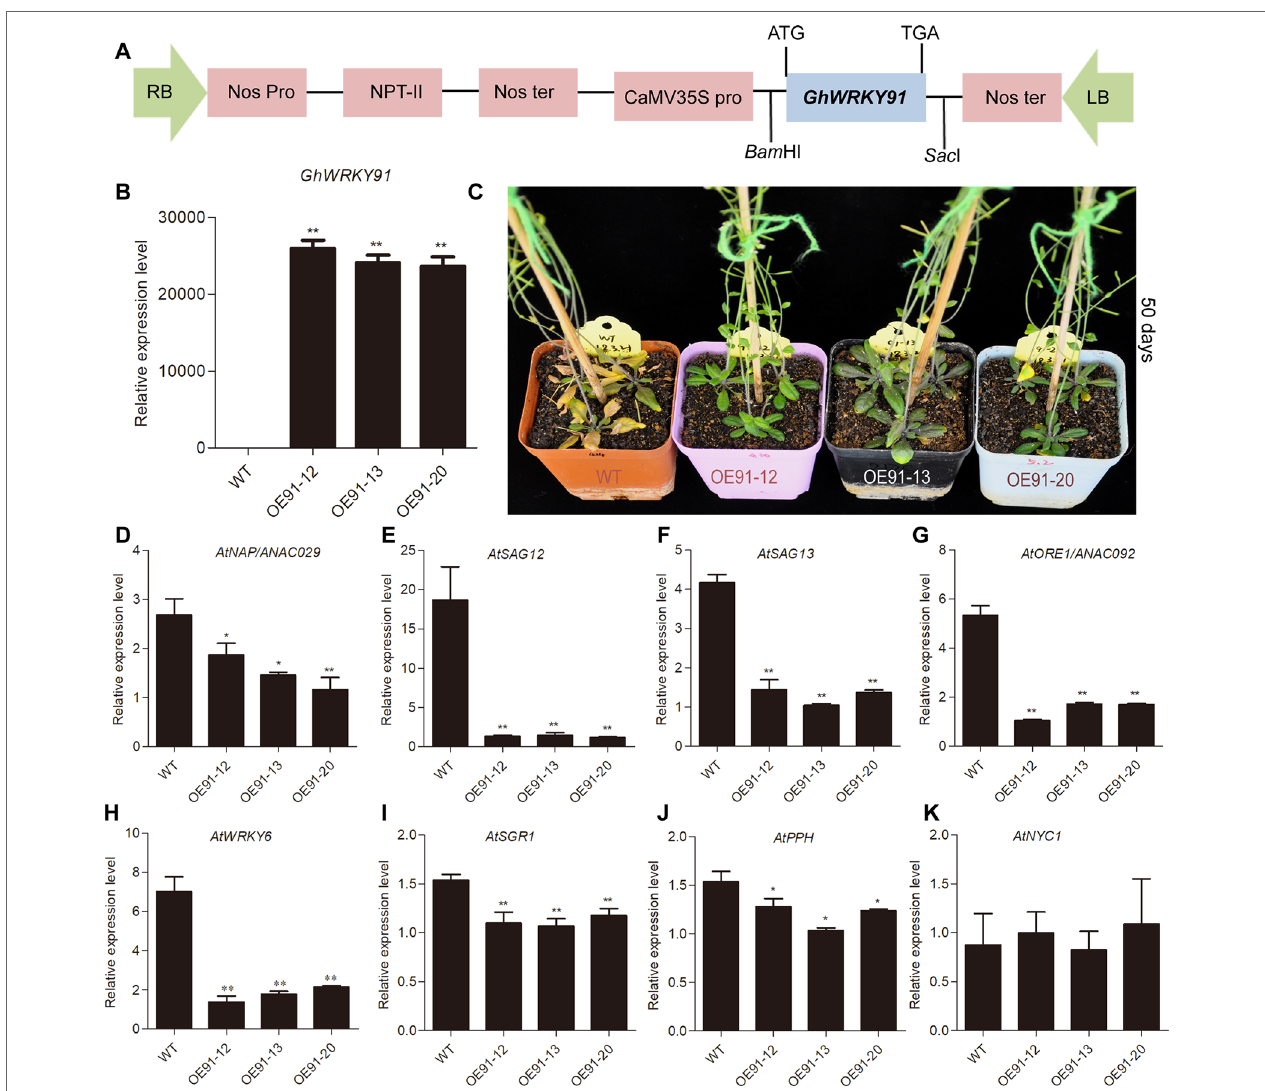
FIGURe 5 | Overexpression of GhWRKY91 in Arabidopsis plants delayed leaf senescence. (a) The T-DNA construction diagram used for Arabidopsis transformation. (B) Transcript levels of GhWRKY91 in WT and transgenic plants. (C) Phenotypic characteristics of WT and transgenic plants grown for 50 days. The seeds of WT and transgenic lines were germinated on 1/2MS agar media in a growth chamber at 22°C under a 16 h light/8 h dark photoperiod. Two-week- old seedlings were then transplanted into soil in a greenhouse at 22 ± 1°C under a 16 h light/8 h dark photoperiod, and the natural senescence phenotype was observed in 50-day-old plants. (D – K) Transcript levels of SAGs in the rosette leaves of WT and transgenic plants grown for 50 days. AtUBQ10 served as the reference gene. The data are the means ± SEs of three biological replicates. **P < 0.01 and *P <